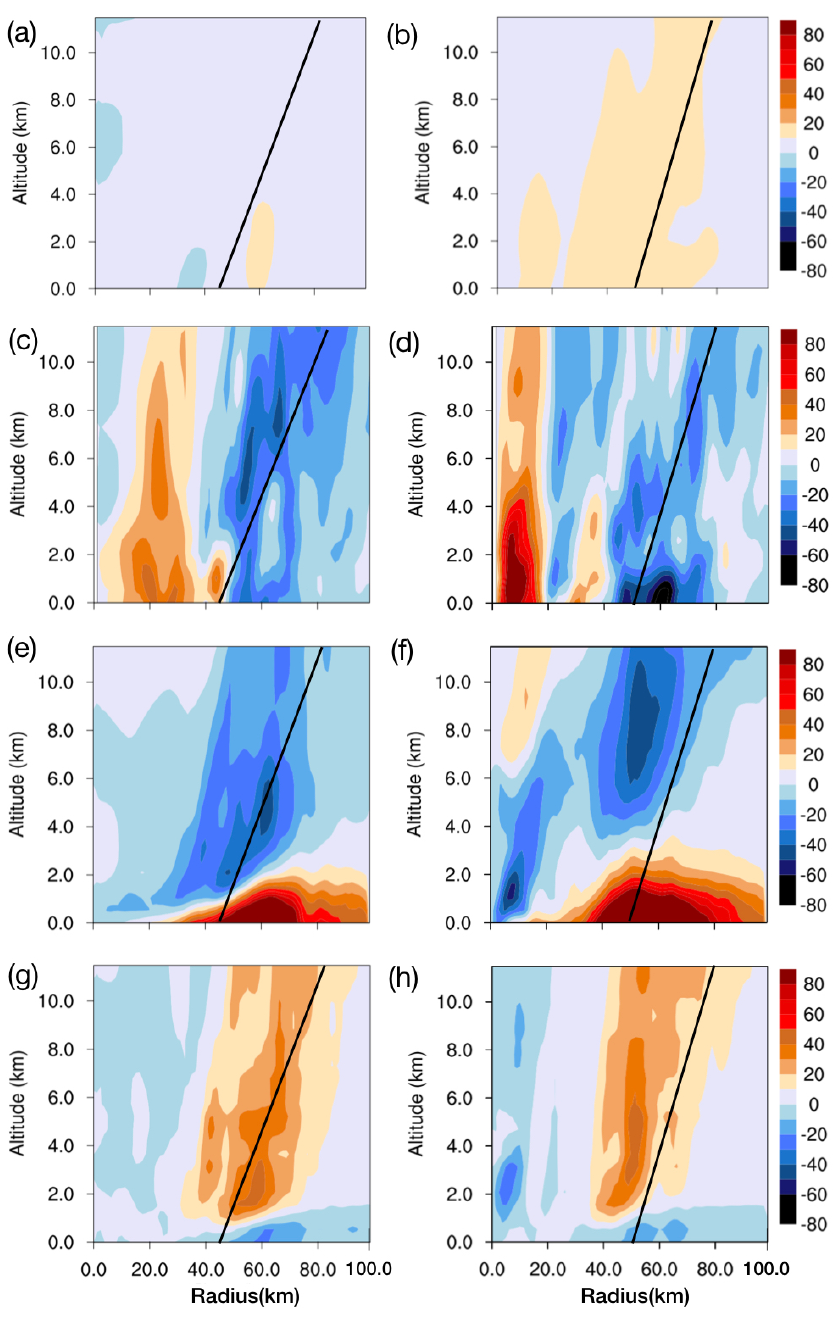
Figure 13. The time integrated azimuthally averaged tangential wind budget (unit: m s − 1 ) in Equation (2) from 1300 UTC to 1700 UTC 22 August for CPL experiment (left column) and FO experiment (right column). Panels ( a , b ) are the azimuthal mean tangential wind tendency ( c , d ) are the mean radial eddy flux (REDY). Panels ( e , f ) are the mean radial advection of the absolute vorticity and panels ( g , h ) are the vertical advection of the absolute vorticity by the vertical motion. The solid lines indicate the roughly RMW at 1700 UTC 22